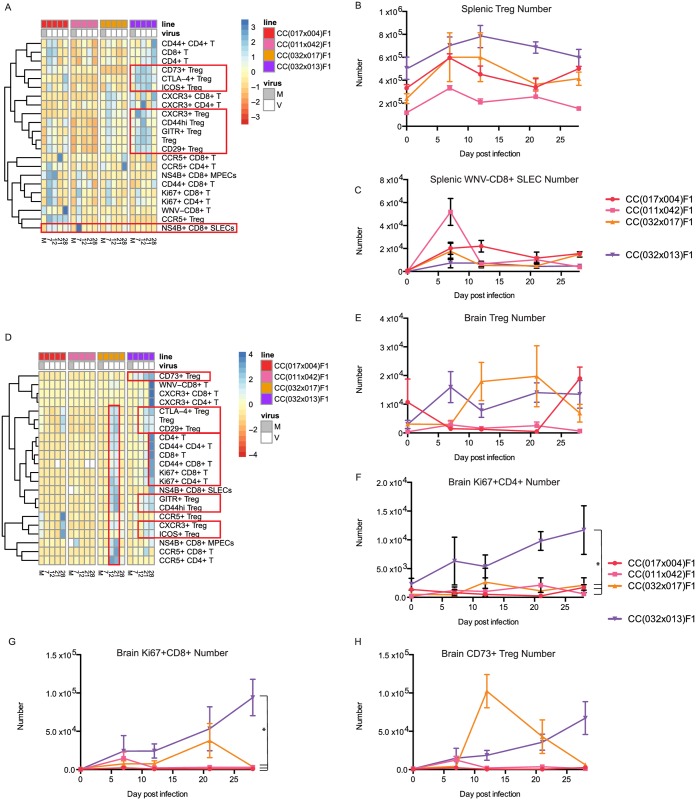
Flow cytometry heatmaps allow visualization of intra- and inter-strain comparisons of the immune response.(A) Three representative “no disease” lines are compared to the chronic line for immunophenotypes measured by mutli-parameter flow cytometry. Infection status and clinical observations are shown in the top module, while flow cytometry data is shown in the heat map below. T cell subsets and activation markers are shown (blue = up, red = down). Compared to the “no disease” RIX lines, the chronic RIX shows increased Treg numbers in the spleen, and increase in activation of those Tregs. Conversely, the chronic RIX shows a lack of expansion in WNV-specific short lived effector cells when compared to the no disease lines (red boxes). (B-C) Total number of splenic Tregs and WNV-CD8+ SLECs, as indicated. At baseline, p = 0.0176 for comparison of splenic Treg numbers from CC(032x013)F1 and CC(011x042), with all others non-significant. At d21 post-infection, differences in splenic Treg number were statistically significant for CC(032x013)F1 compared to CC(017x004)F1, CC(011x042)F1, and CC(032x017)F1 (p = 0.0440, 0.0159, and 0.0316, respectively). At d7 post-infection, p = 0.0232 for comparison of splenic WNV-CD8+ SLECs from CC(032x013)F1 and CC(011x042)F1, with all other comparisons p>0.05. (D) Flow cytometry heatmap of brain immunophenotypes from the same “no disease” and chronic lines. (E-G) Total number of brain Tregs, Ki67+ CD4 T cells, Ki67+ CD8 T cells, and CD73+ Tregs, as indicated. At d7 post-infection, differences in brain Treg number were statistically significant for CC(032x013)F1 compared to CC(017x004)F1, CC(011x042)F1, and CC(032x017)F1 (p<0.05). At d28 post-infection, differences in brain Ki67+ CD4+ T cell number were statistically significant for CC(032x013)F1 compared to CC(017x004)F1, CC(011x042)F1, and CC(032x017)F1 (p<0.05). N = 3 mice per group for all time points shown.